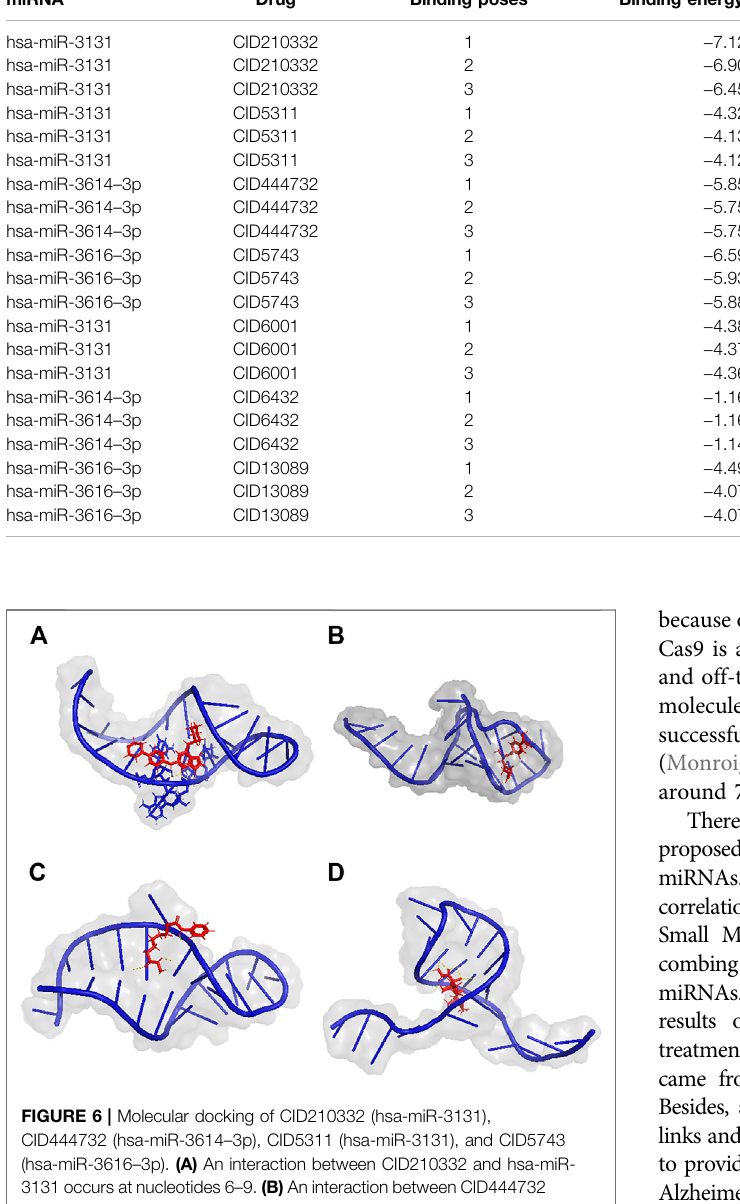
TABLE 5 | Docking results of selected positive and negative pairs of miRNAs and small molecules. miRNA Drug Binding poses Binding energy (kcal/mol)